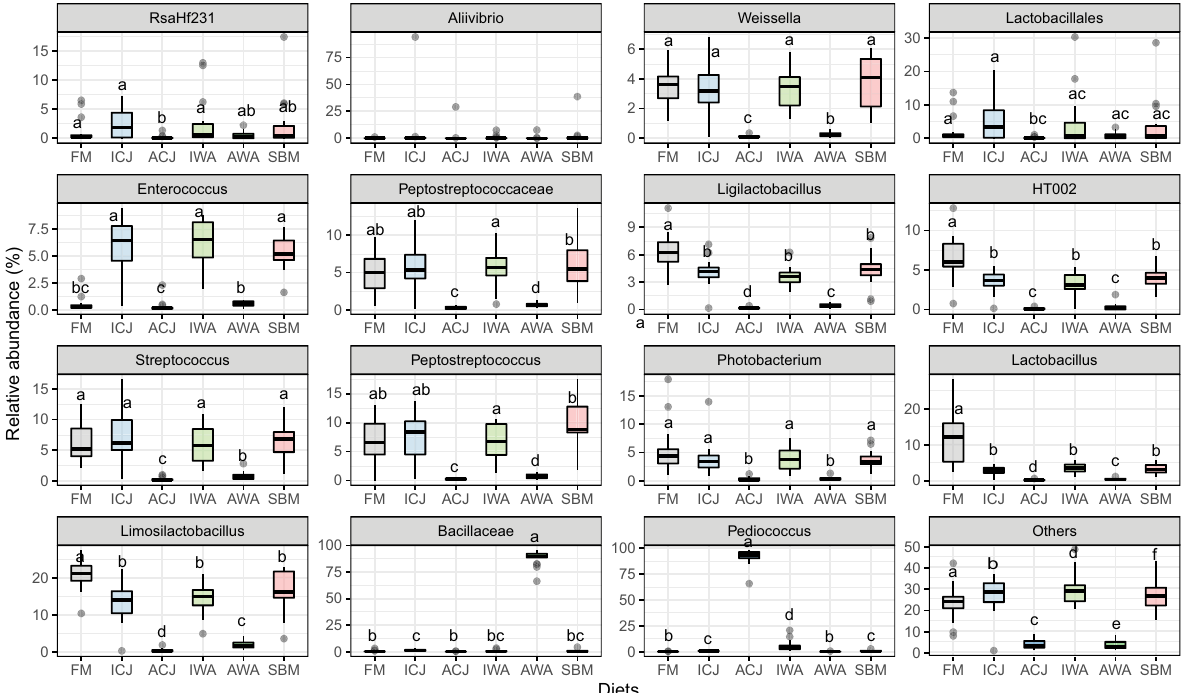
Fig. 3 Boxplots of relative abundance of the top 15 most abundant taxa (at genus or lowest taxonomic rank) in the digesta of fish fed the experimental diets. The samples are grouped by diets; FM—fishmeal-based; SBM—soybean meal-based; 4 experimental diets containing 300 g/ kg SBM and 100 g/kg of ICJ—inactivated Cyberlindnera jadinii ; ACJ—autolyzed C. jadinii ; IWA—inactivated Wickerhamomyces anomalus ; AWA— autolyzed W. anomalus diets. Different lower-case letters represent taxa with significantly different ( p < 0.05) relative abundance among the